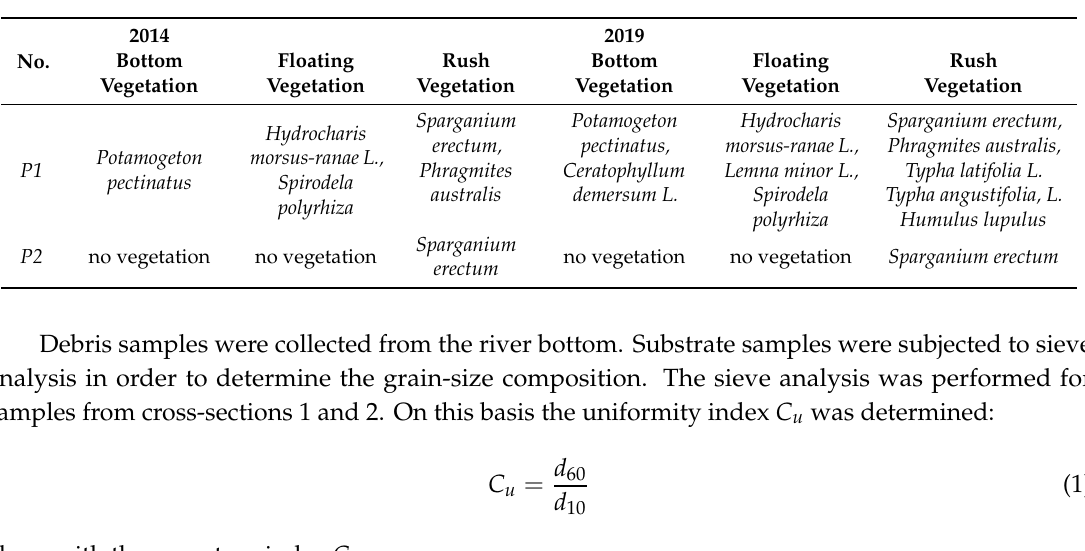
Table 1. Plant species in individual sampling